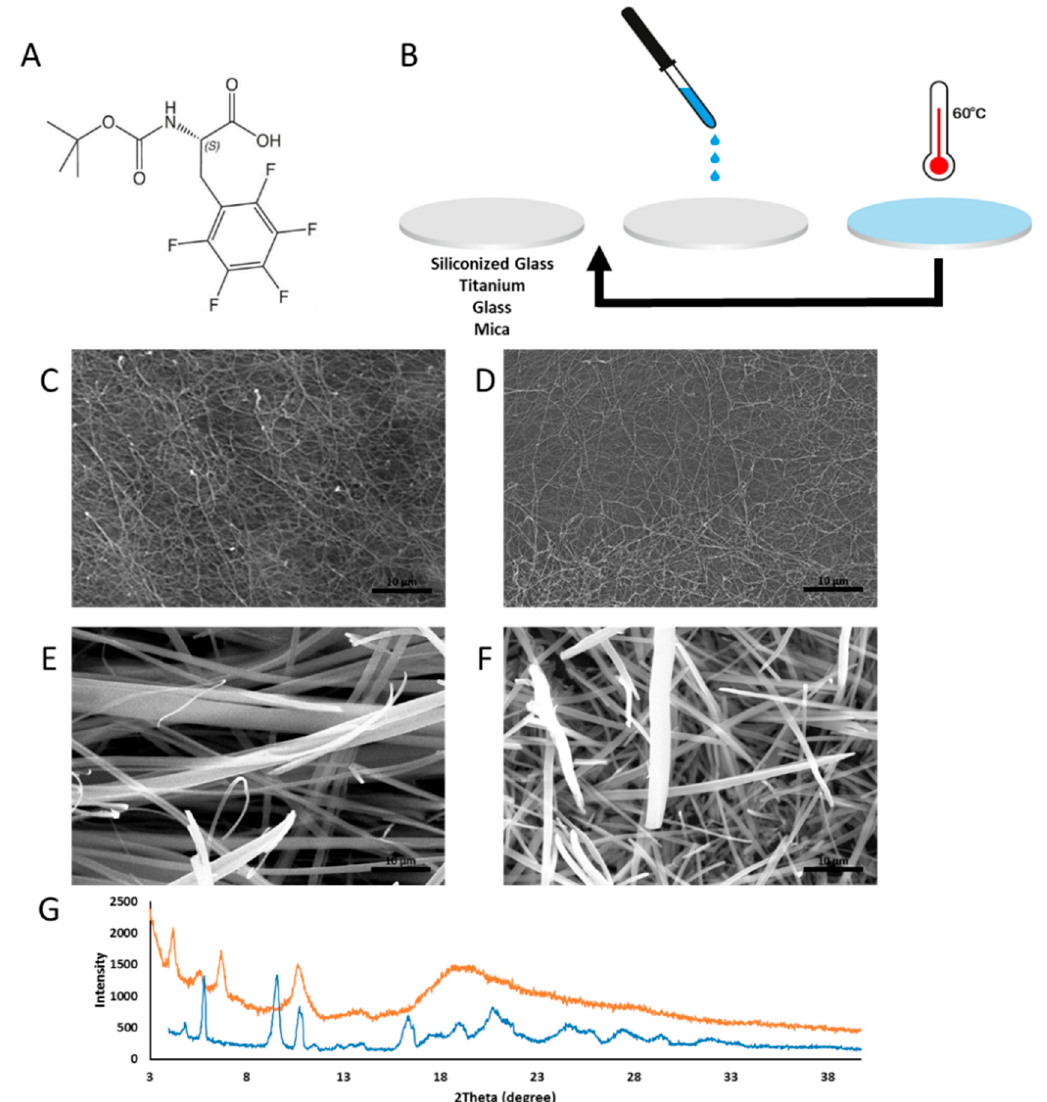
Figure 2. Characterization of the Boc-F 5 -Phe coating. ( A ) Molecular structure of the modified amino acid Boc-F 5 -Phe. ( B ) Schematic illustration of the modified drop-cast technique for surface modification of siliconized glass, titanium, glass and mica surfaces. The arrow represents the repetition of the drop-casting process and heating of the stages. ( C , D ) SEM structural characterization of Boc-F 5 -Phe-coated ( C ) titanium surface and ( D ) siliconized glass surface before stability test. ( E , F ) Boc-F 5 -Phe-coated ( E ) titanium and ( F ) siliconized glass after stability test (Scale bar 10 µm). ( G ) XRD structural analysis of Boc-F 5 -Phe-coated glass surface before (orange) and after (blue) stability test.